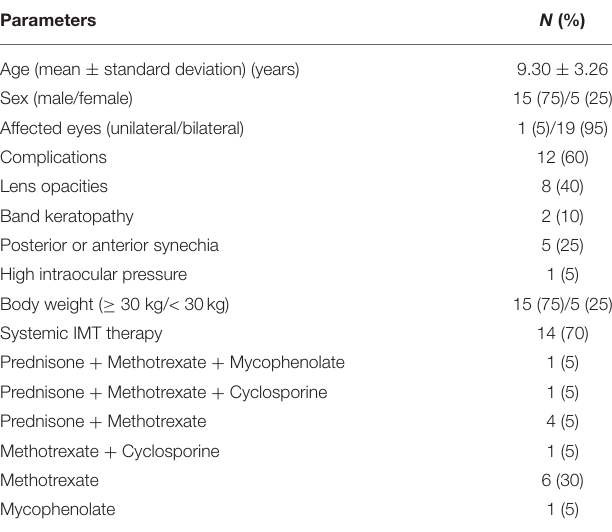
TABLE 2 | Baseline features of the included patients when adalimumab was initiated.